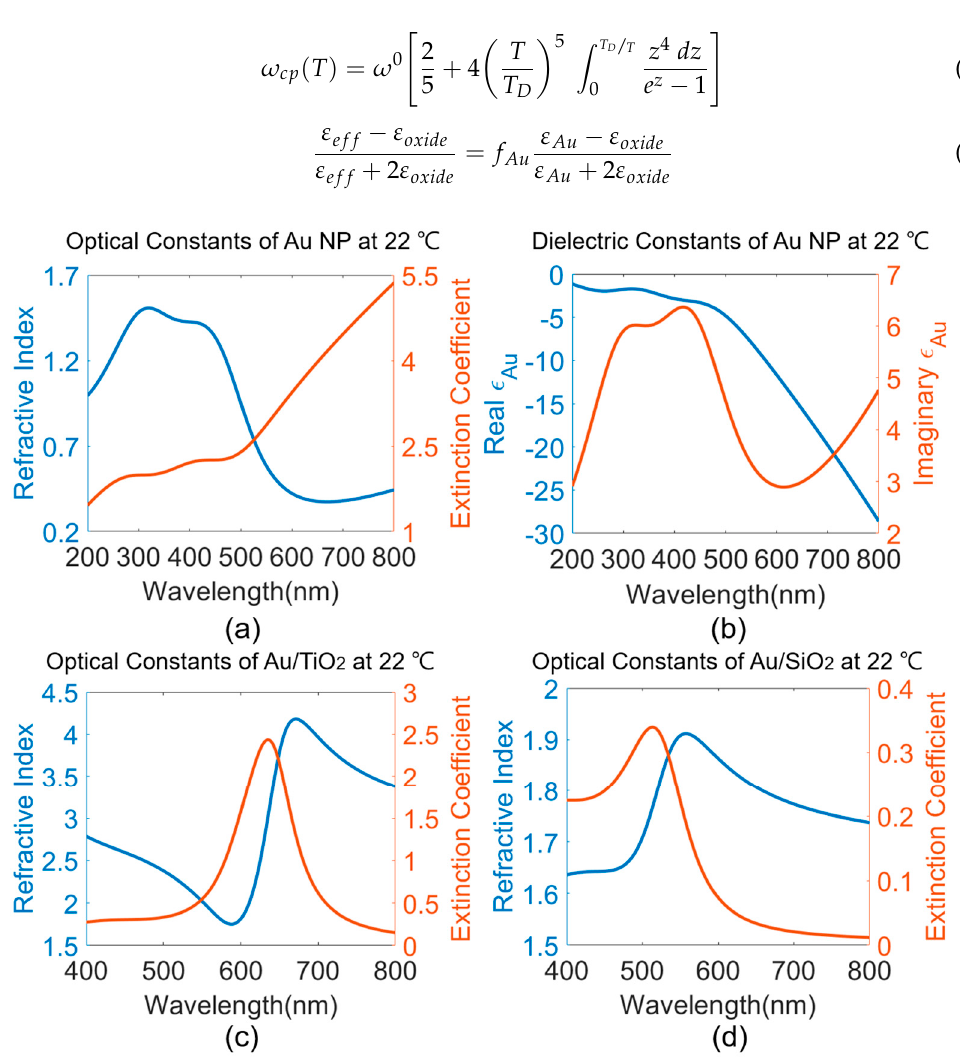
Figure 8. ( a ) Optical constant model, ( b ) associated real and imaginary dielectric constants of Au nanoparticles at room temperature. Effective optical constant model of ( c ) Au/TiO 2 nanocomposite, nanoparticles at room temperature. E ff ective optical constant model of ( c ) Au/TiO 2 nanocomposite, and ( d ) Au/SiO 2 nanocomposite simulated at room and ( d ) Au/SiO 2 nanocomposite simulated at room temperature.